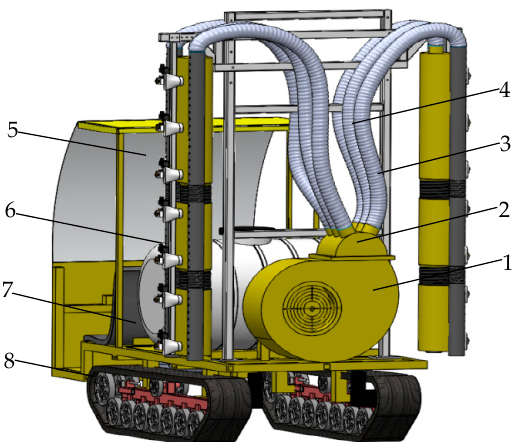
Figure 1. Structure diagram of the V-shaped anti-drift spray device in multi-airflow synergy: 1. Centrifugal fan; 2. Distributor; 3. Frame; 4. Conveying air duct; 5. Auxiliary air duct; 6. Main air duct; 7. Medicine box; 8. Crawler chassis.